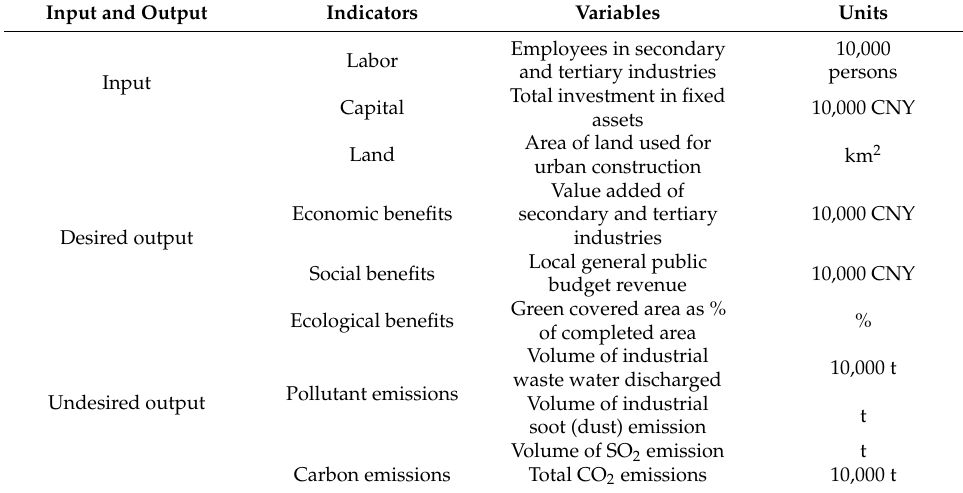
Table 1. The indicators for ULGUE evaluation.